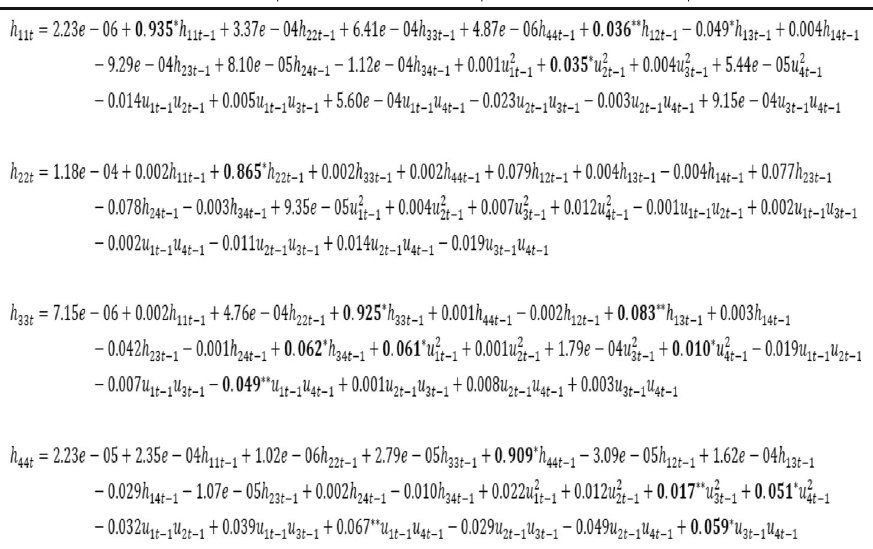
Table 6 Conditional variance equations for EU butter, palm oil and crude oil prices